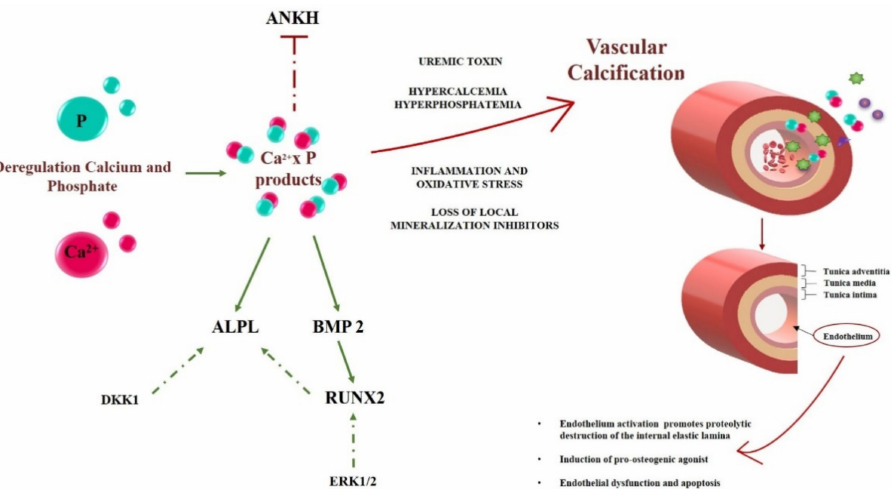
Figure 1. A schematic representation of the early steps of the calcification process in CKD. Deregula- tion of calcium (Ca 2+ , in red) and phosphate (P, in green) are key events initiating and promoting vascular calcification. Various genes and proteins involved in the endothelium mineralization are reported in the left part of the figure, where active and inactive genes are underscored in a green or red color, respectively. The dashed green lines represent a secondary pathway involved in gene activation. With various contributions from uremic toxins, inflammation and oxidative stress, as well as the loss of local inhibitors, the system evolves toward calcification, according to mechanisms which are still unclear and partly related to the scope of the present work. On the right half of the Figure, a schematic structure of a blood vessel and the role of the endothelium modifications are reported. Calcium, Ca 2+ ; Phosphate, P; Inorganic Pyrophosphate Transport Regulator, ANKH ; Bone Morphogenetic Protein 2, BMP2 ; tissue-nonspecific alkaline phosphatase, ALPL ; RUNX Family Transcription Factor 2, RUNX2 ; Dickkopf WNT Signaling Pathway Inhibitor 1, DKK1 ; Extracellular signal-regulated 1/2,